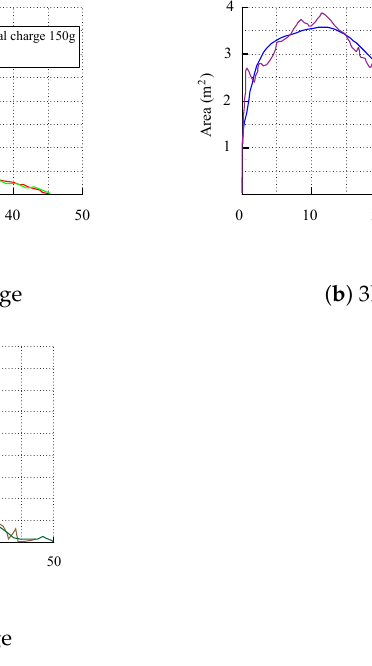
Figure 9. Area of combustion behind the shock